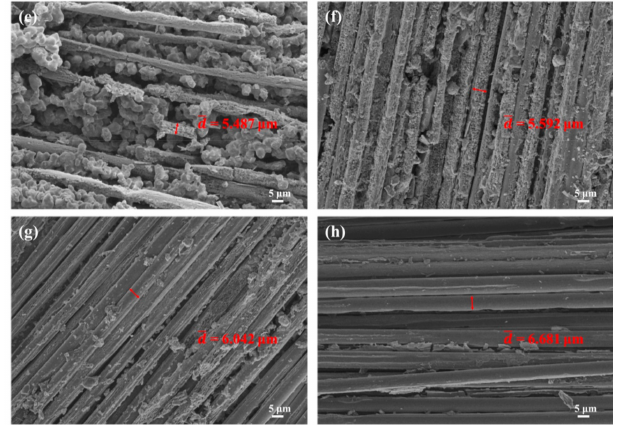
Figure 5. Micromorphology of BP-0 and BP-15 treated at different temperatures for 15 min: BP-0 at ( h ) 1400 ◦ C. Table 3. Diameter changes of carbon fibers treated at different temperatures. Treatment Temperature